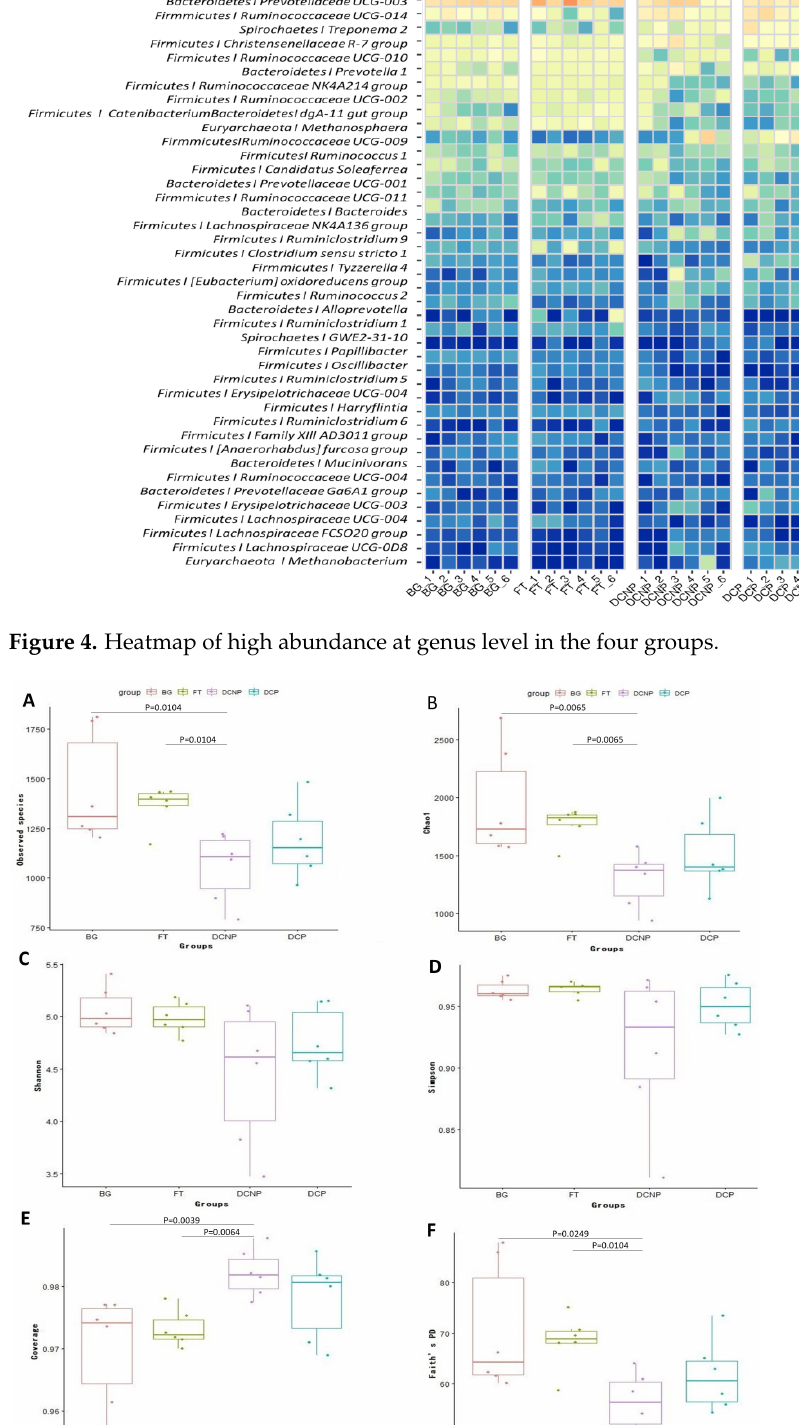
Figure 5. Box-plot representation of alpha diversity among four groups. The number of observed OTUs ( A ), Chao1 ( B ), Shannon ( C ), Simpson ( D ), Coverage ( E ) and Faith’s PD ( F ) among the four groups.